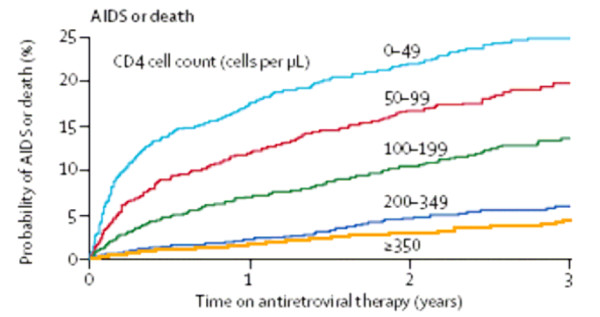
Kaplan Meier plots of the probability of progression to AIDS or death according to baseline CD4 count [20] (reproduced with permission).